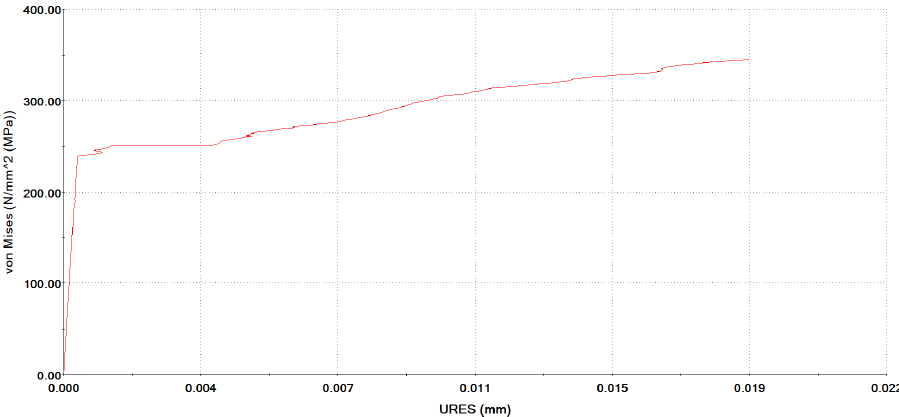
Figure 35. Graph of stress changing with respect to displacement in the center of the specimen along the simulation’s steps .